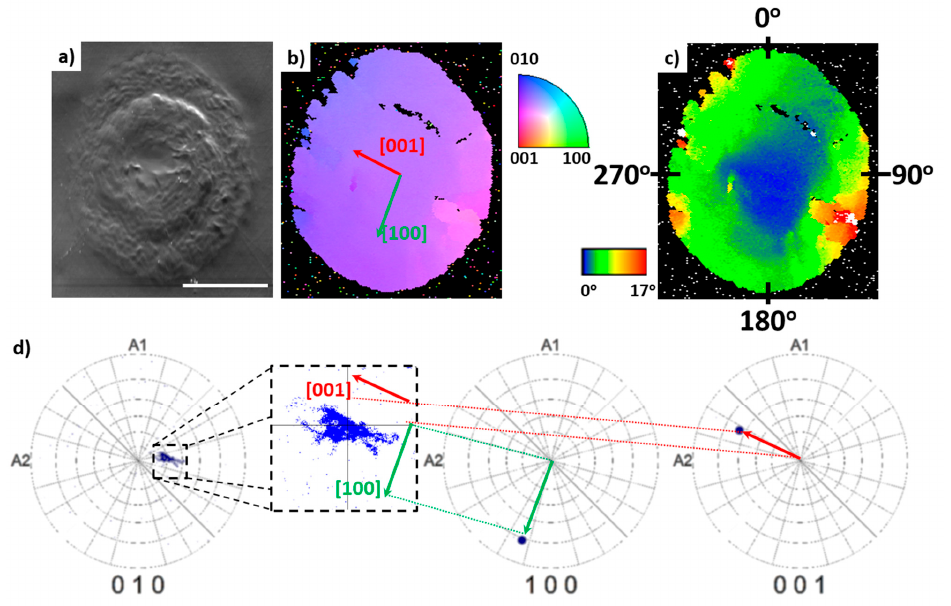
Figure 4. Sb 2 S 3 single crystal dot #1 fabricated using ‘ring’ procedure on the surface of Sb 2 S 3 glass: ( a ) SEM image, ( b ) colored inverse pole figure (IPF) map with reference vector normal to the sample surface (ND), ( c ) crystal orientation deviation (COD) map with reference to crystal orientation at the center of the dot, the marked numbers indicate positions along the crystal edges in degrees, and ( d ) pole figure (PF) maps in the (010), (100), and (001) crystallographic directions of the crystal dot. The inset represents an enlarged version of the (010) pole figure. The arrows on IPF ( b ) and PF ( d ) maps describe the direction of the lattice cell. Scale bar corresponds to 10 µm.